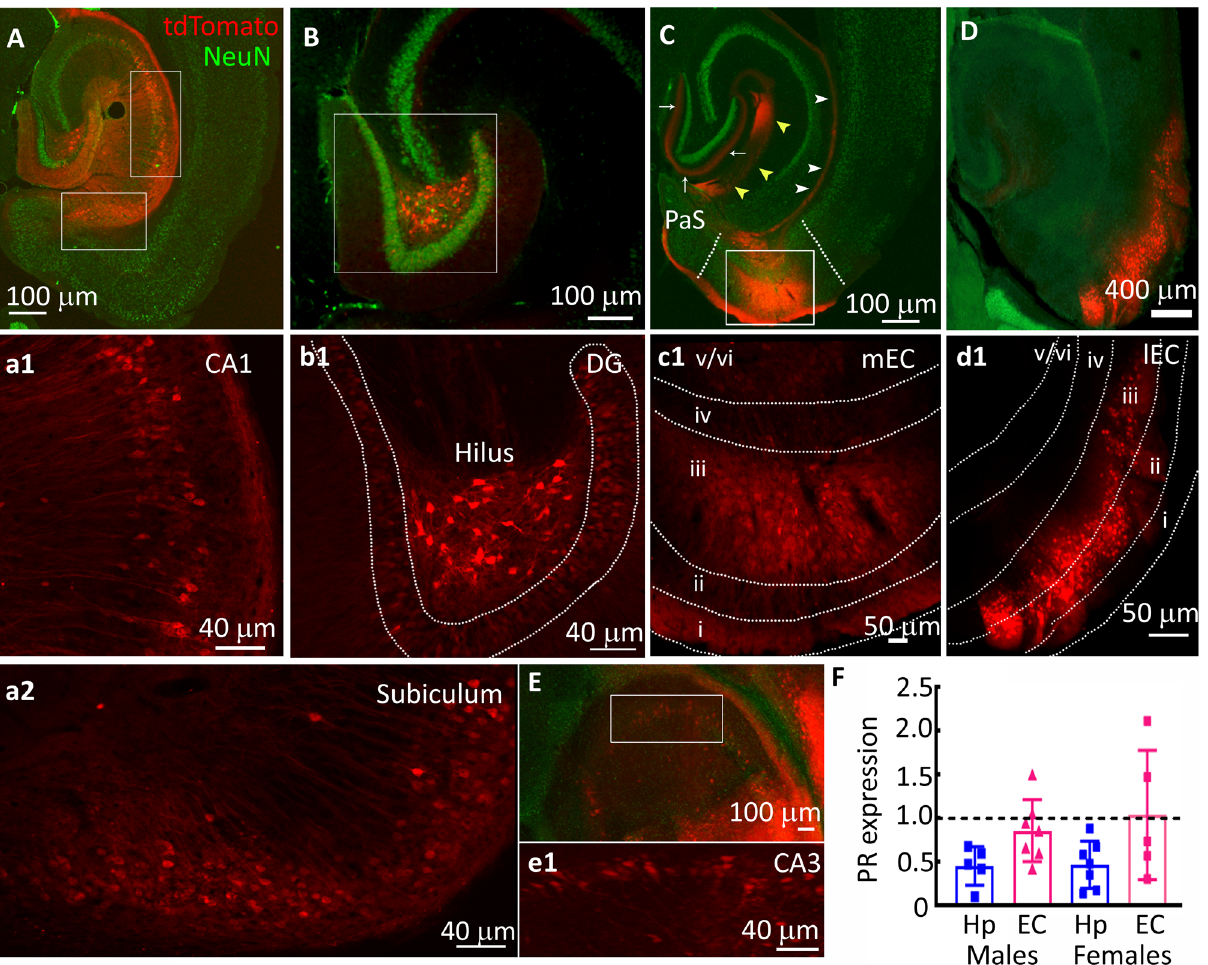
Figure 1. PR expression in the EC and hippocampus of adult male mice. ( A – E ) Images from representative Pgr-Cre animals injected with AAV9 expressing a flexed-tdTomato. The AAVs were injected into the hippocampus and EC. The sections were counterstained with a neuronal marker protein NeuN (Green) to label neurons. The tdTomato labeled terminals of the perforant path (white arrows), temporoammonic pathway (white arrowheads), and temporoammonic Alvear path fibers (yellow arrowheads) are also marked in 1C. ( a1 , a2 , b1 – e1 ) Magnified boxed regions from A-E showing neuronal tdTomato expression. ( F ) PR mRNA expression in the EC and hippocampus (Hp) of male mice, n = 7 for EC and 5 for Hp. The PR mRNA expression (1.12 ± 0.29, n = 7) in the uterine tissue isolated from females in the estrus stage of the cycle was used for normalization (dotted black line). The expression of PR mRNA in the EC and Hp tissue isolated from female mice in the estrus stage is shown for comparison (n = 5 EC and 7